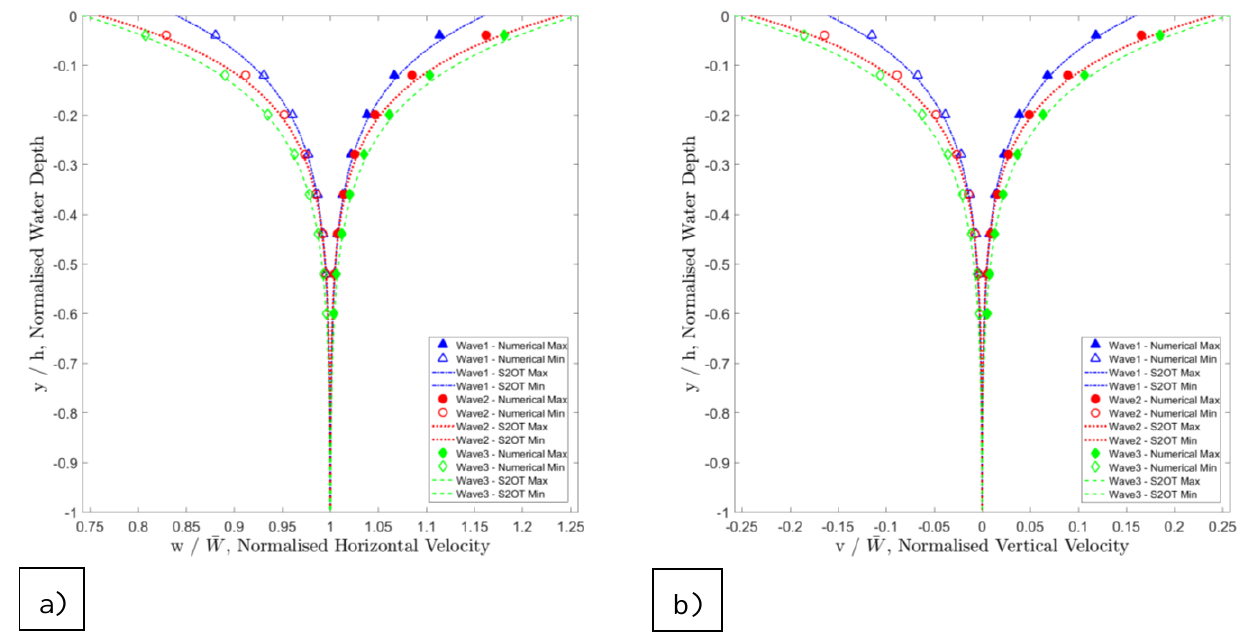
Figure 13. The normalized a) horizontal and; b) vertical velocities at monitor points through the water depth at a location 4m downstream of the inlet for numerical results and S2OT.